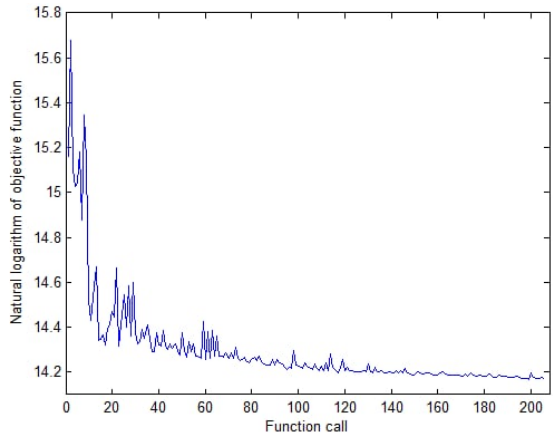
Figure 8. Progress of the objective function (6) during optimization.